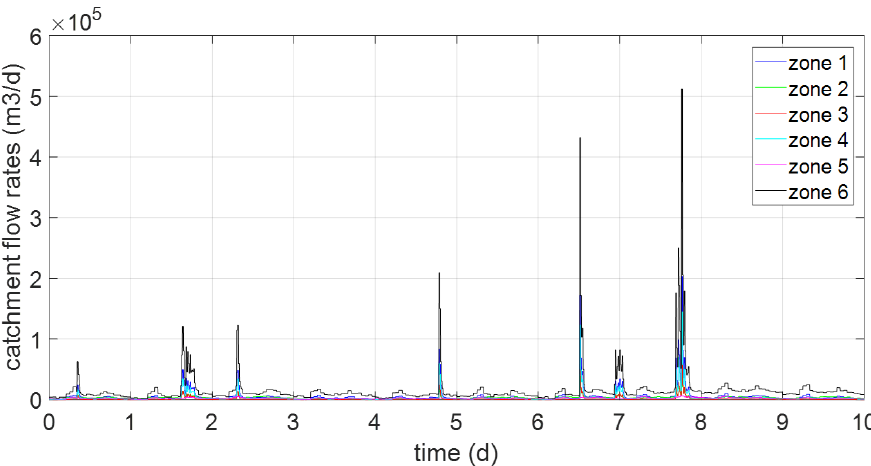
Figure 10. Scenario